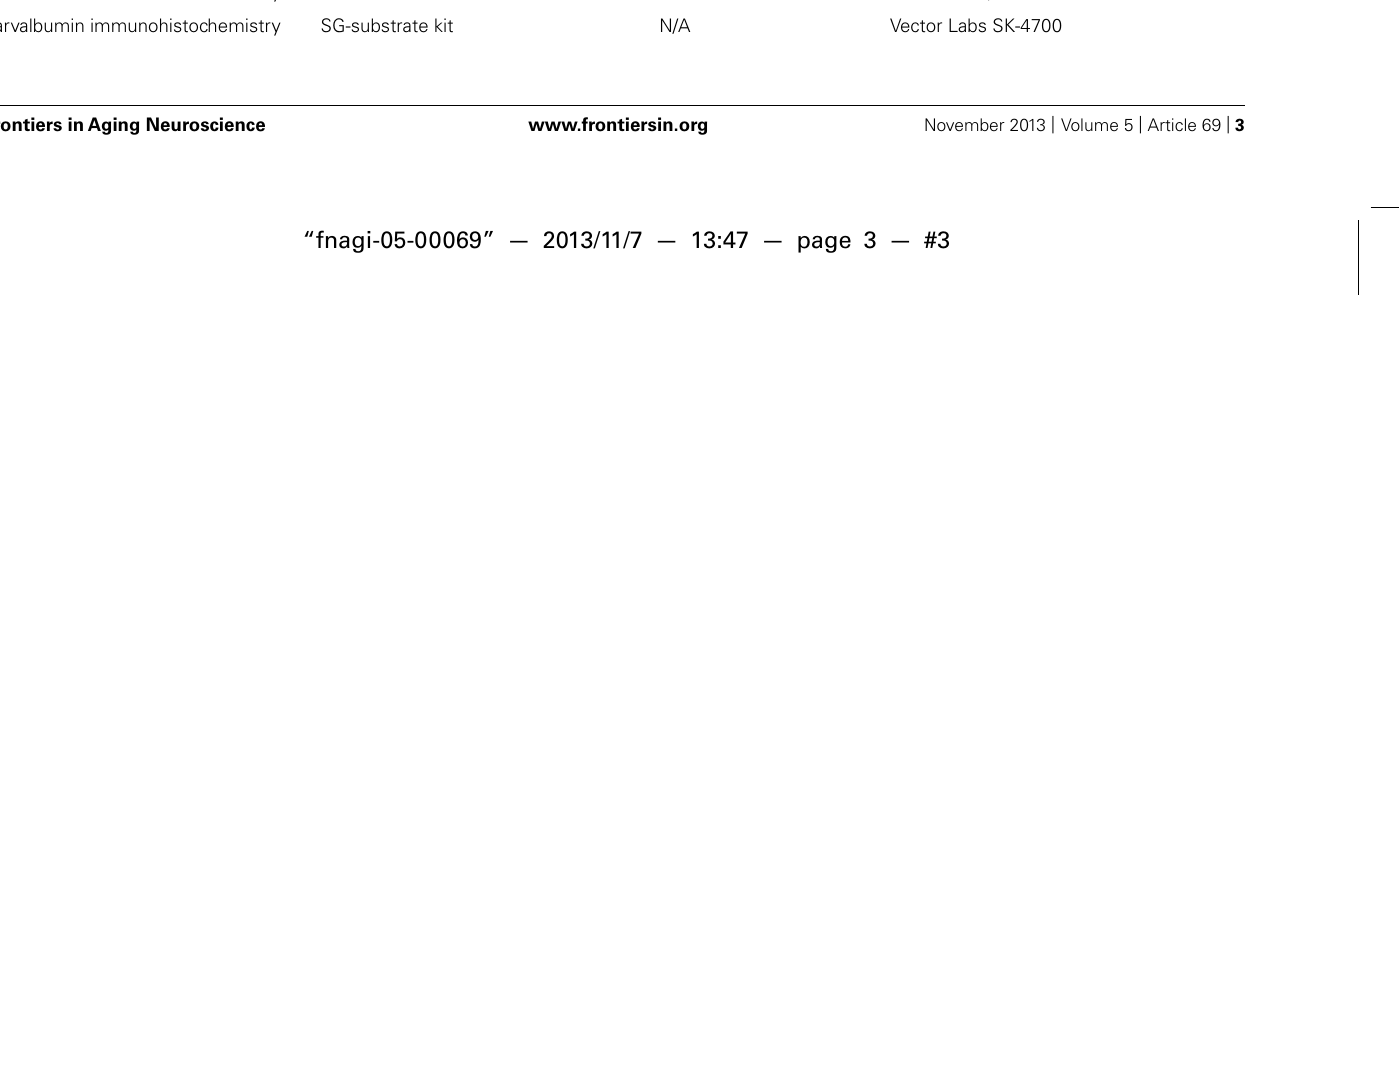
Table 2 | Information on the antibodies and chemicals used for immunohistochemical and histochemical reactions.